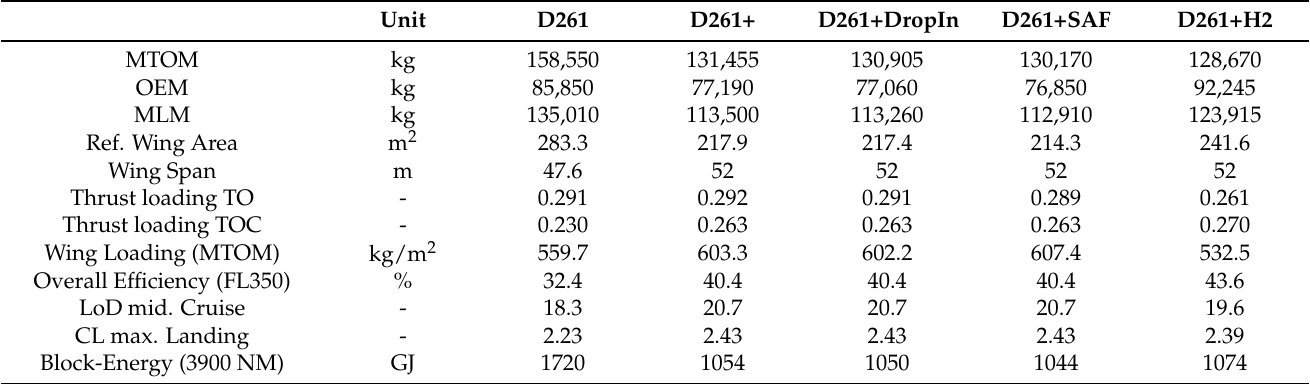
Table 5. General aircraft